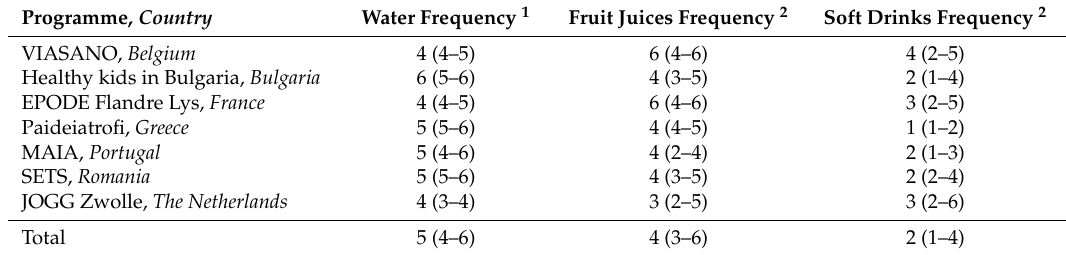
Table 2. Rounded median values and quartiles (q 1 –q 3 ) for weekly beverage intake per country.